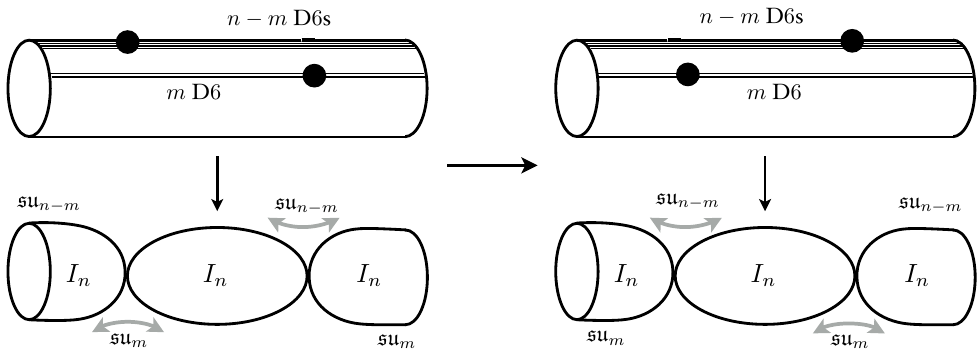
Figure 7 . A smooth transition, in IIA and in F-theory.